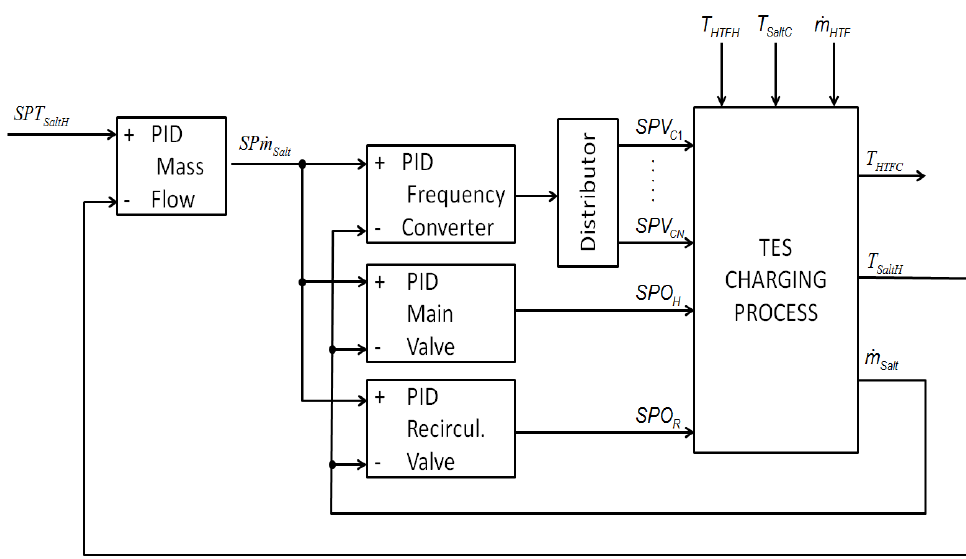
Figure 11. PID regulator in a TES charge process.